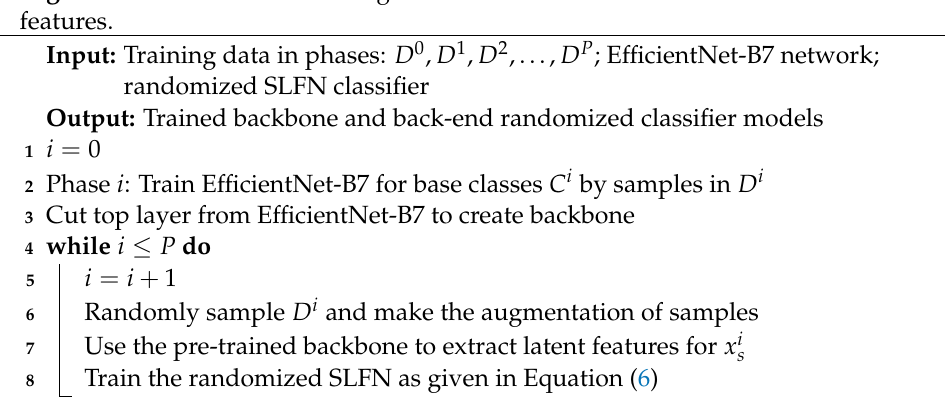
Algorithm 1: Incremental training with few shots with randomized EfficientNet